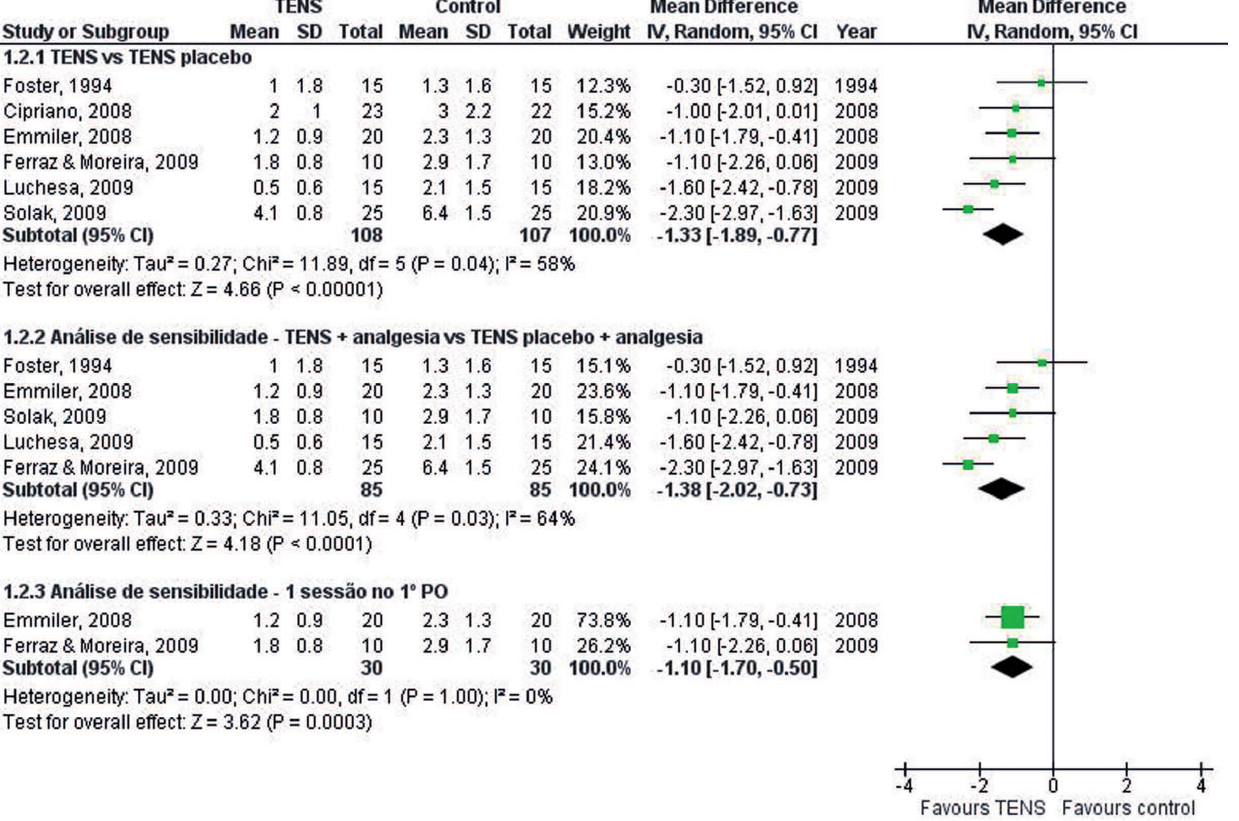
Fig. 3 – Análise da dor referente aos estudos que realizaram cirurgia com abordagem por esternotomia mediana: comparação da TENS vs. TENS placebo. TENS = estimulação elétrica nervosa